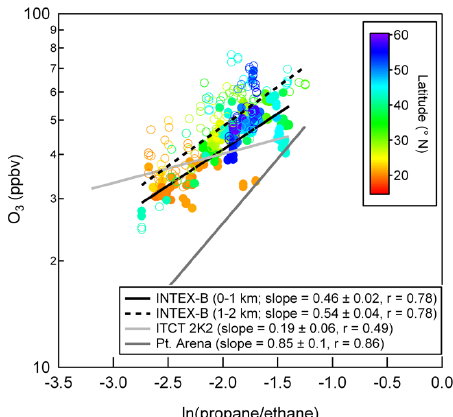
Figure 8 : Correlation of the measured O 3 concentrations with the natural log of the propane to 604 Fig. 8. Correlation of the measured O 3 concentrations with the nat- ethane ratio in the marine boundary layer during INTEX-B. Linear least squares fits determined 605 ural log of the propane to ethane ratio in the marine boundary layer using data from ITCT 2K2 and Pt. Arena, CA are included for comparison Parrish et al. [2004]. 606 607 during INTEX-B. Linear least squares fits determined using data 608 from ITCT 2K2 and Pt. Arena, CA are included for comparison 609 Parrish et al.